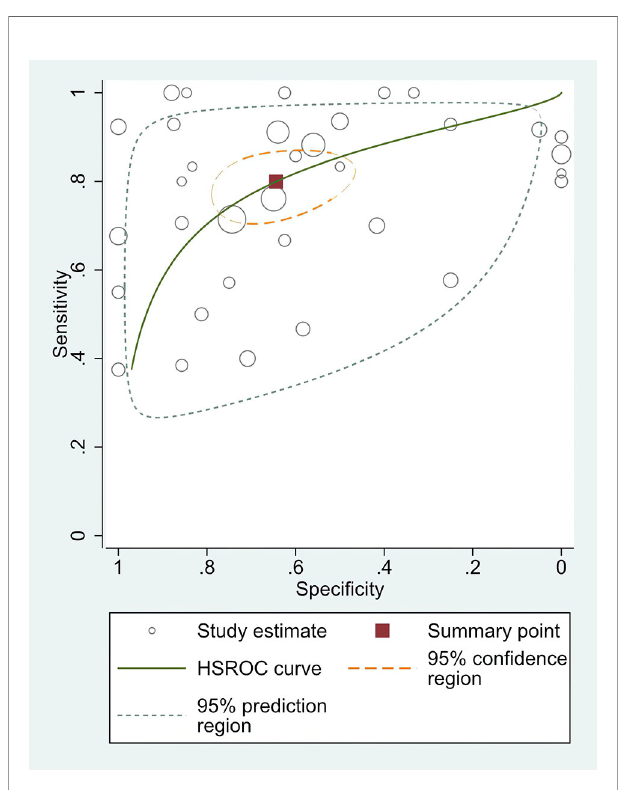
FIGURE 11 | The HSROC curve of the differential diagnostic value of histology in MPLC and IPM.